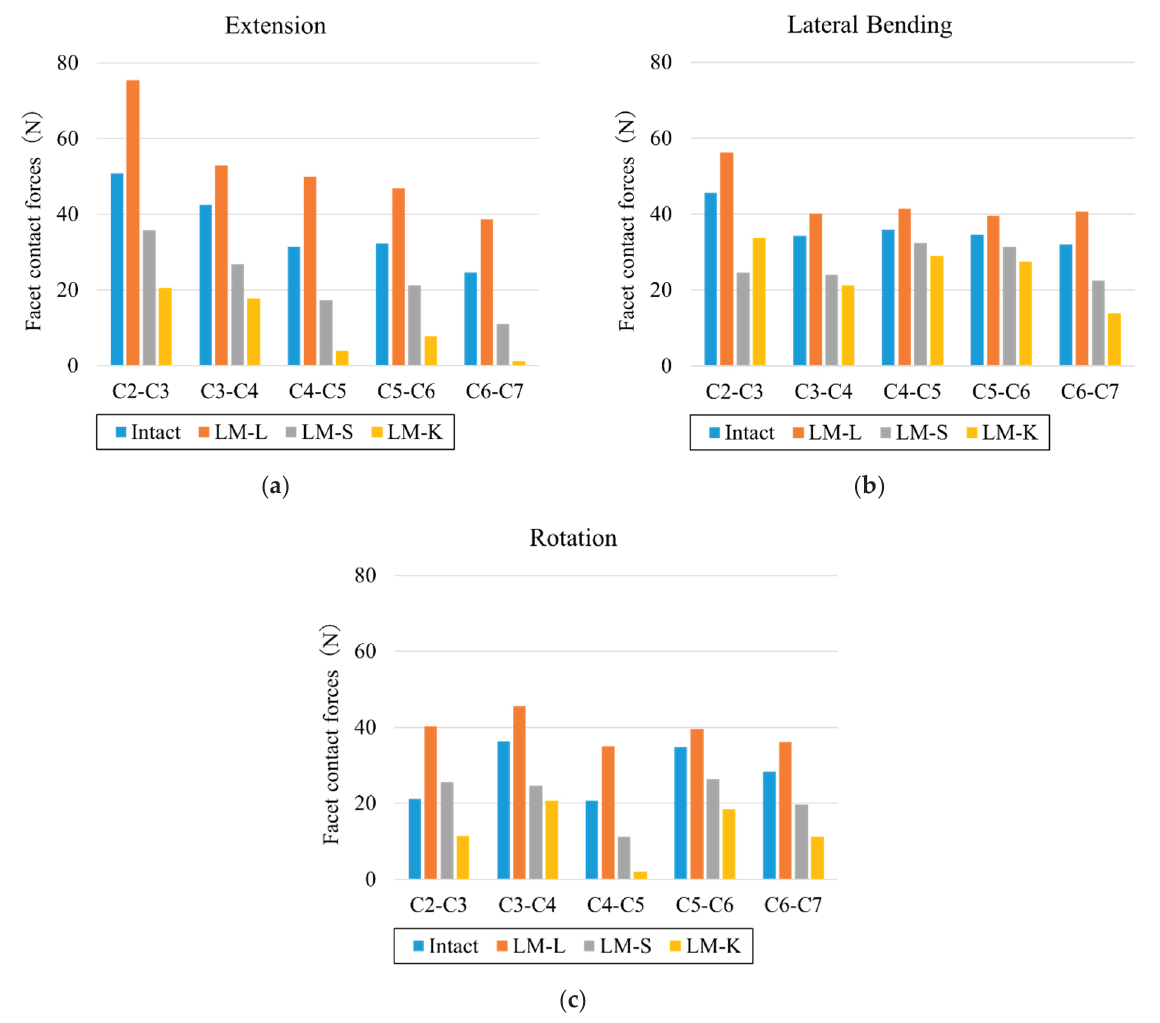
Figure 5. Facet contact forces. ( a ) extension, ( b ) lateral bending, ( c ) axial rotation. Vertical axis is force (N), horizontal axis is each intervertebral level.